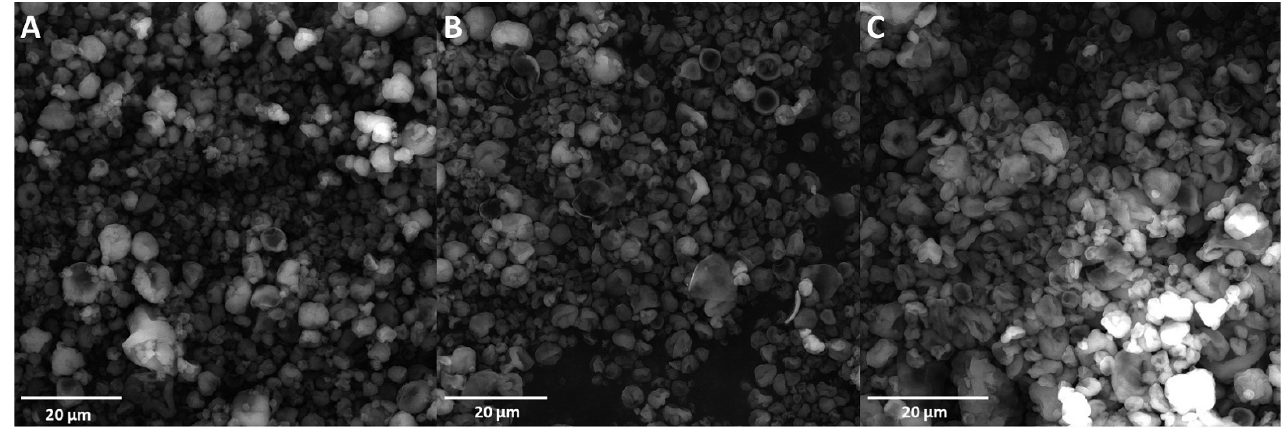
Figure 2. SEM images of CPC spray-dried powders. ( A )—sample spray-dried at 140 °C; ( B )—sample spray-dried at 160 °C; ( C )—sample spray-dried at 180 °C. Table 1. The effect of spray-drying conditions on tapped bulk density, flowability, cohesiveness, particle size and Total Solids Content (TSC) of experimental powders. Tapped Sample